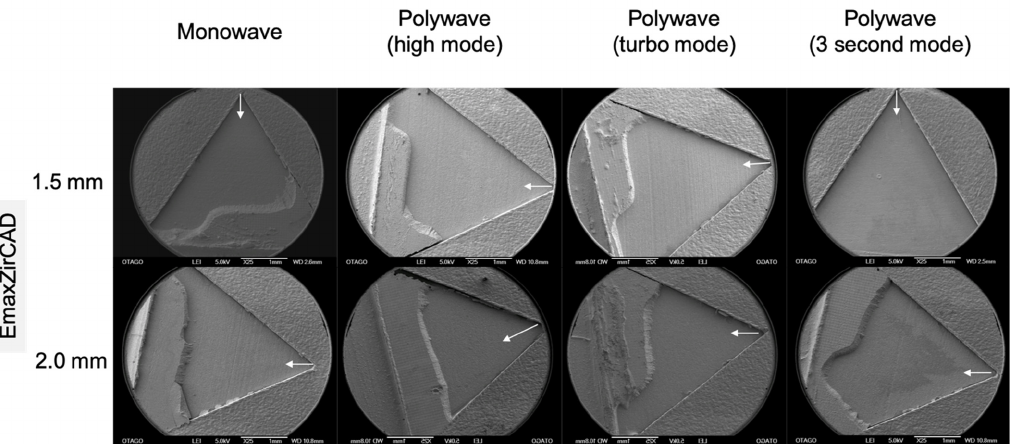
Figure 8. SEM images of bonded specimens between EmaxZirCAD and resin cement at 25 x magni- fication to show overall mode of failure. The arrow is positioned at the tip of the chevron notch and shows the direction of crack